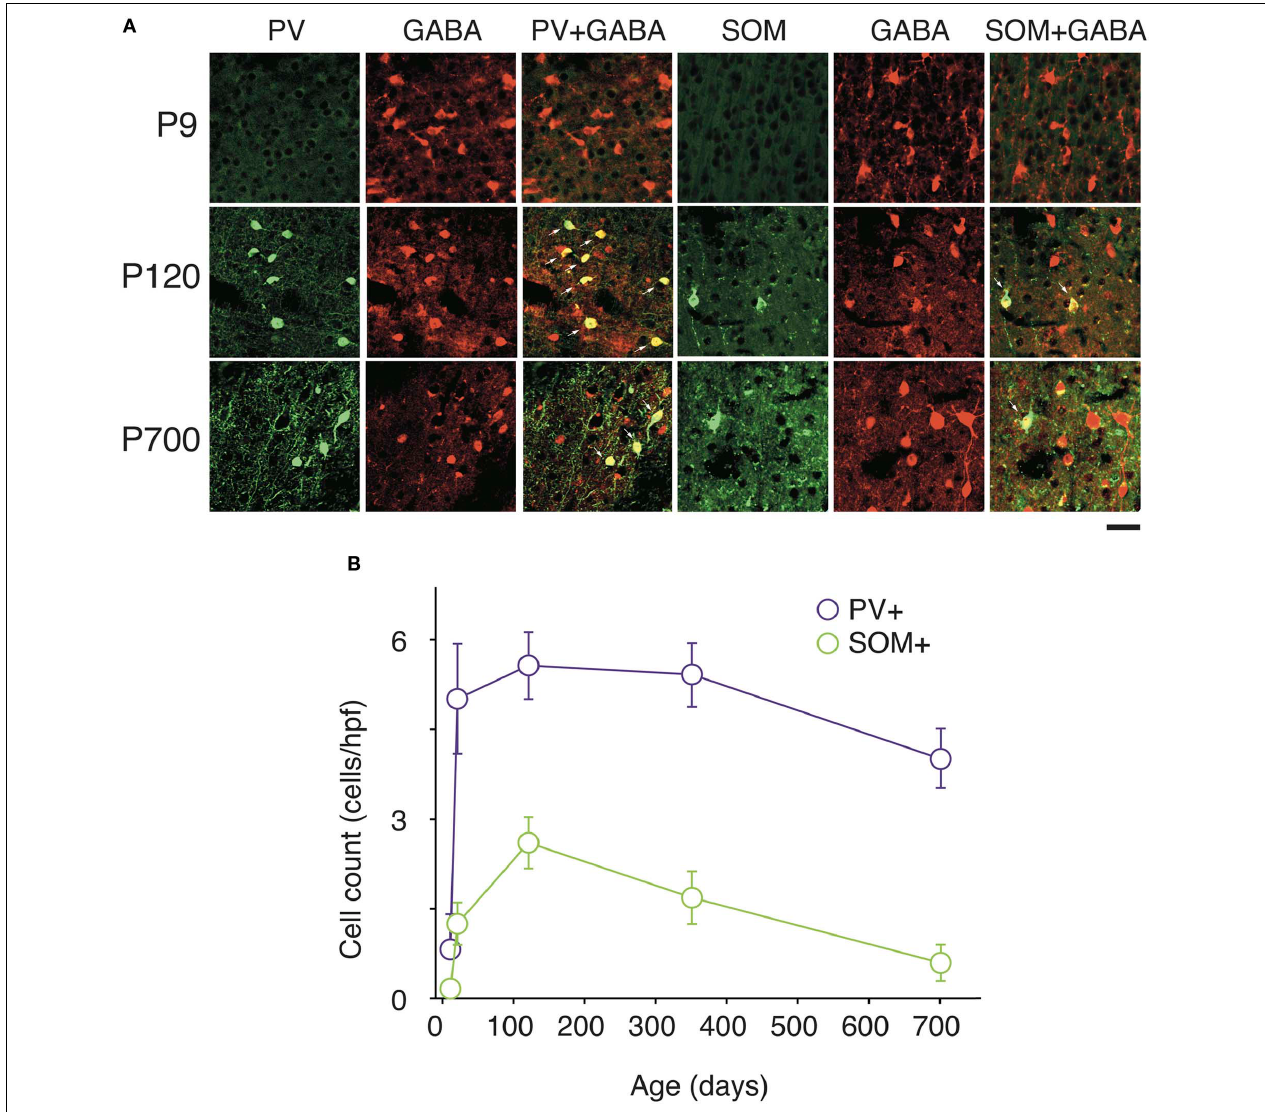
FIGURE 4 | Changes in PV and SOM markers expression in A1 GABAergic neurons with natural aging. (A) Representative high power confocal photomicrographs of PV + and SOM + immunolabeled cells costained for GABA at each three age intervals. Note that all PV and SOM